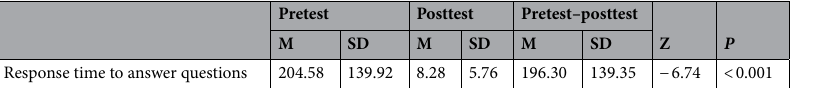
Table 4. Comparison of response time (seconds) to answer questions asked by patients and their families before and after setting up the ER digital bedside